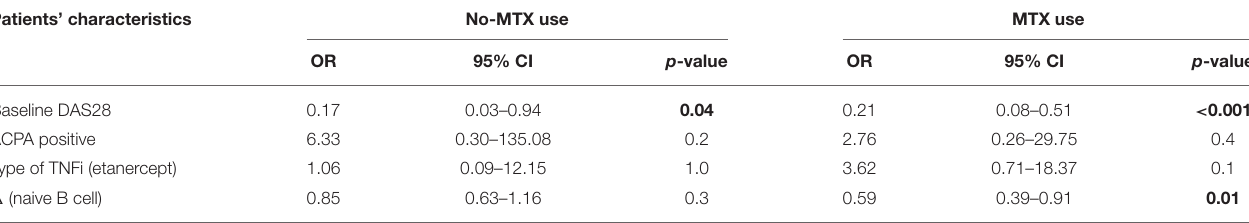
TABLE 3 | Analysis of the association between 1 (naive B cell) and clinical remission (DAS28 ≤ 2.6) after 6 months of TNFi treatment, stratified by the concomitant use of MTX. Patients’